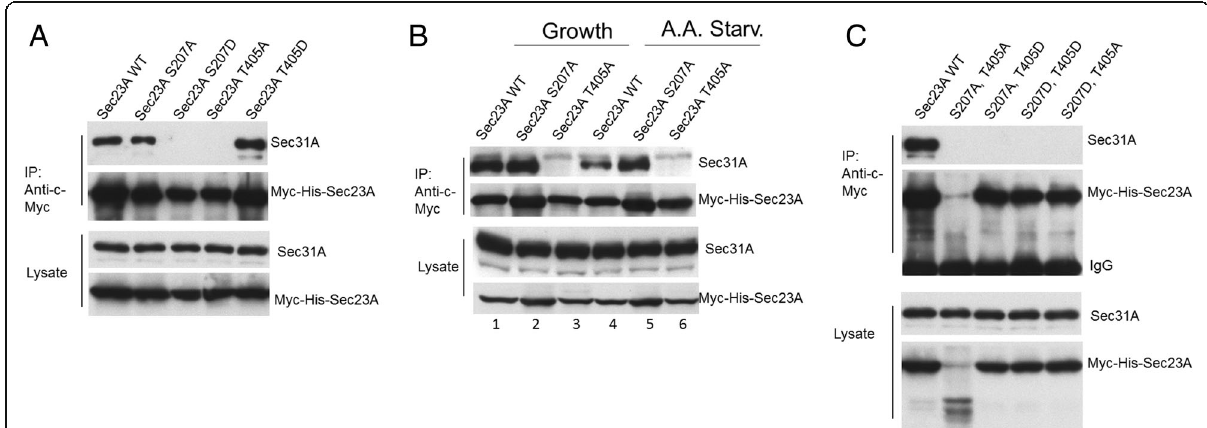
Fig. 6 The interactions between the ULK1 phosphorylation mutants of Sec23A and endogenous Sec31A. a S207 and T405 mutants of Sec23A were tested for their interaction with Sec31A in normal growth condition. The indicated Myc-His-Sec23A mutants were transfected into cells and tested for their ability to bring down endogenous Sec31A in co-IP experiment. b Wildtype Sec23A, S207A and T405A mutants were tested for the interaction with Sec31A in growth medium or in amino acid starved medium EBSS. c Combinations of S207 and T405 double mutants were tested for the interaction with Sec31A. Overexpression of the indicated protein was carried in HEK293T cells, followed by immunoprecipitation of Myc-His-Sec23A by anti-Myc antibody. Co-precipitated endogenous Sec31A was detected by anti-Sec31A antibody